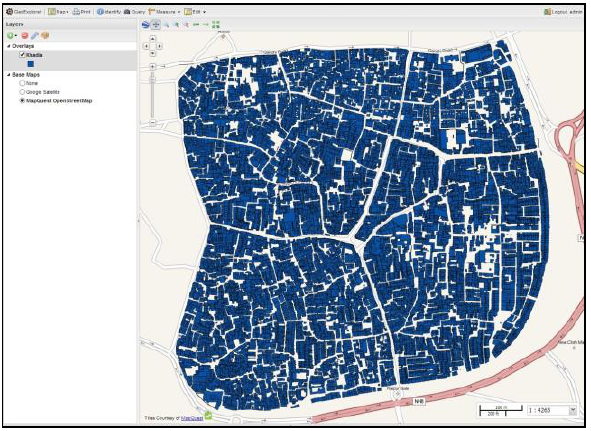
Figure 6. Base map for display on GeoExplorer